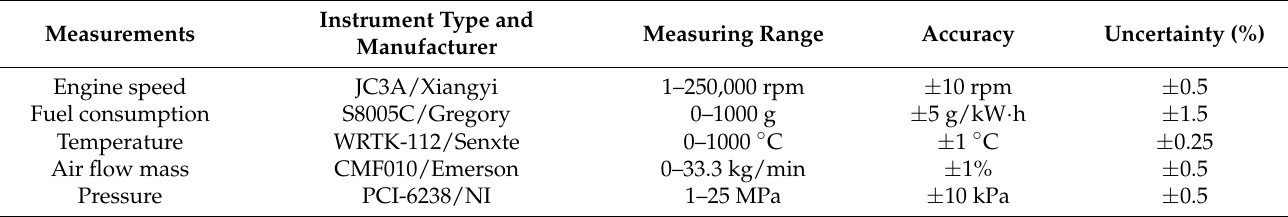
Figure 2. Main equipment in the test bench. Table 1. The measurement range and error of each